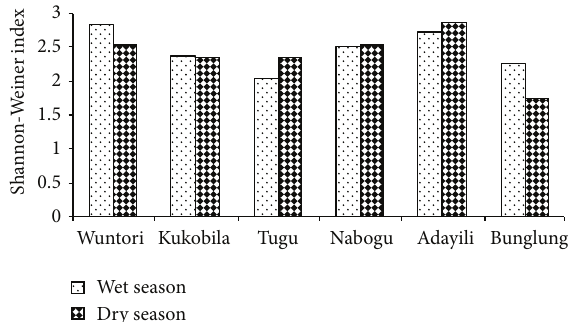
individual sites, Wuntori ( 𝐻 󸀠 = 2.7) and Adayilli ( 𝐻 󸀠 = 2.6) wetlands were significantly diverse and species rich ( 𝑝 <